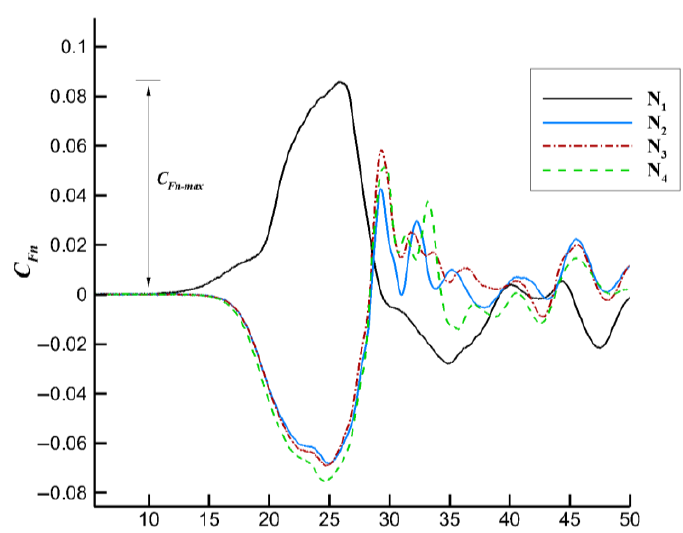
Figure 7. Graphs of C Fn on the cylinder vs. time t for various cases.